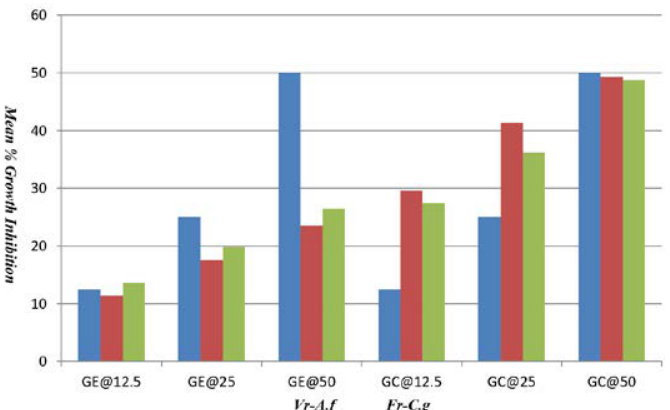
Fig. 8. Mean percentage growth inhibition of Psidium guajava leaf extract (ethanol and chloroform) against Aspergillus niger and Candida glabrata